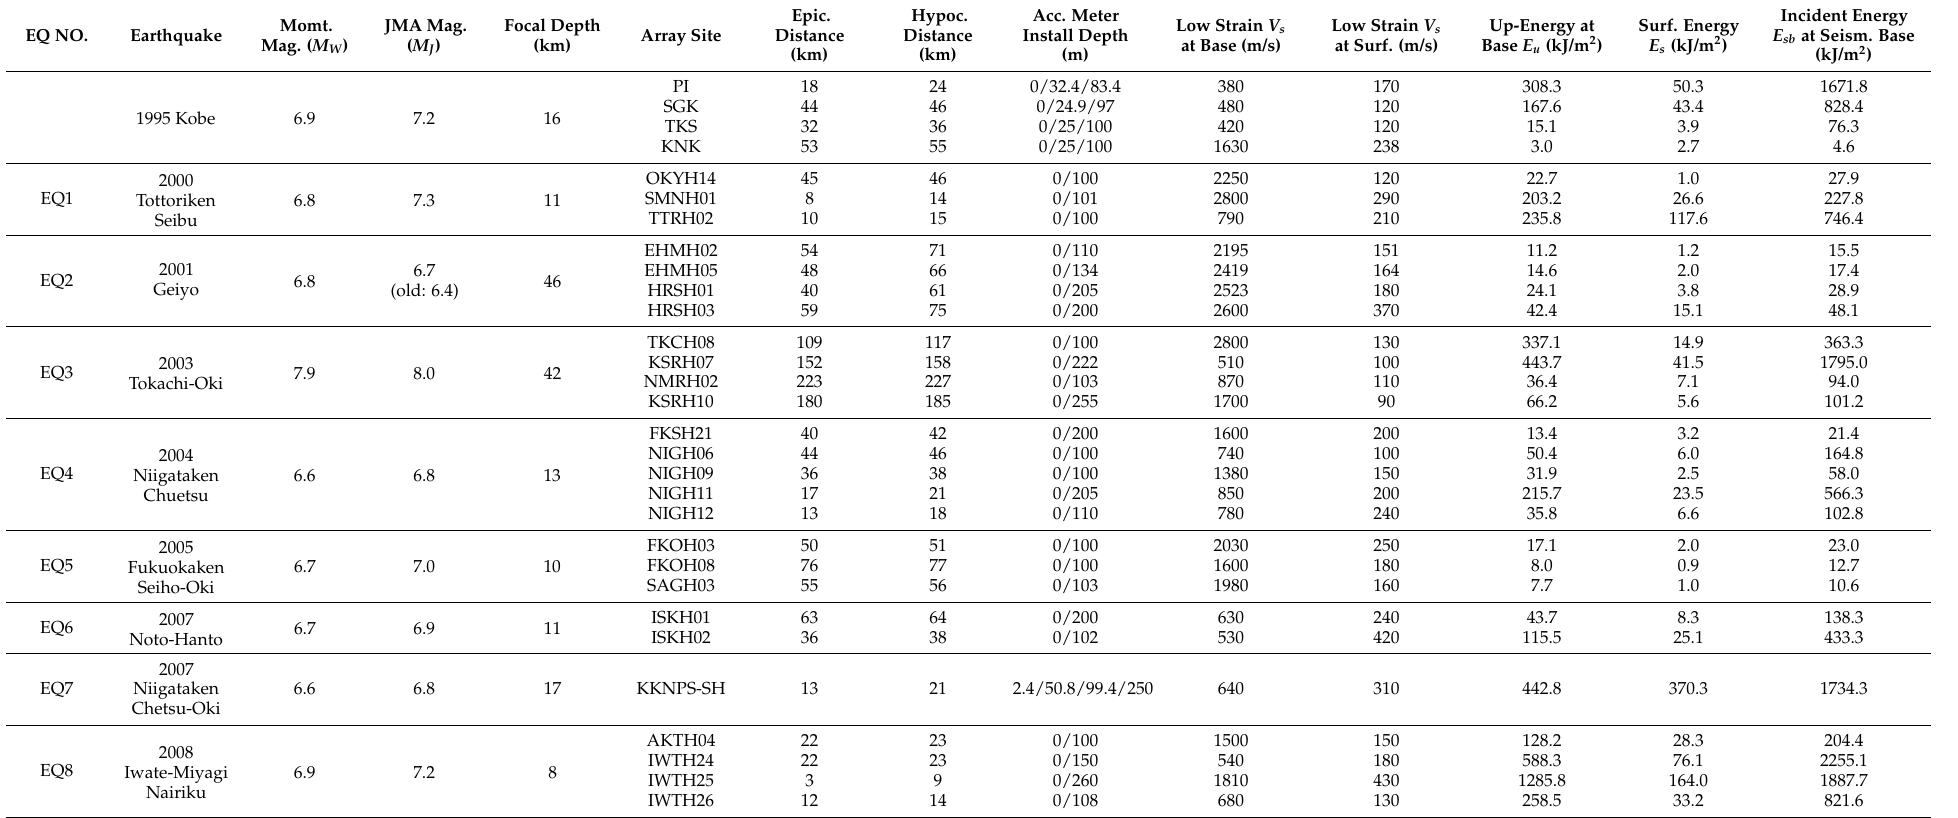
Table 1. Nine strong earthquakes and 30 vertical array sites with associated